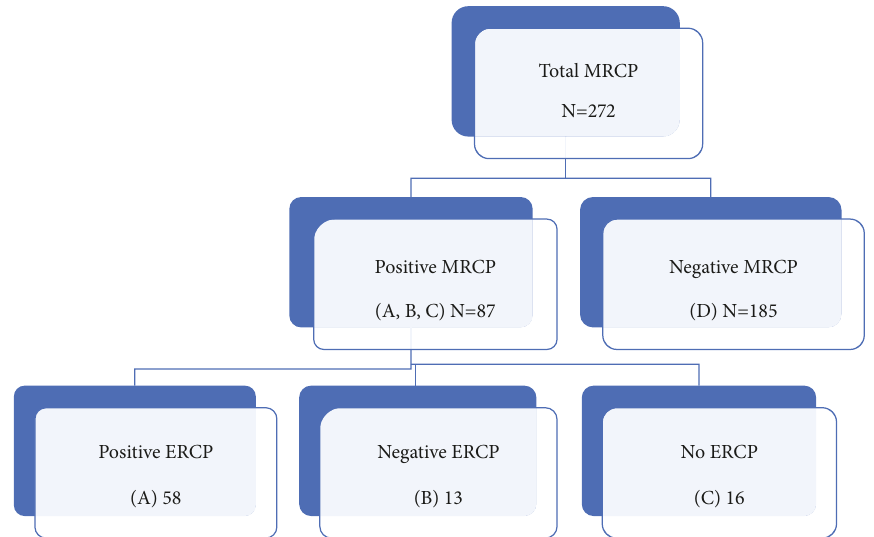
Figure 1: Flow chart of the study